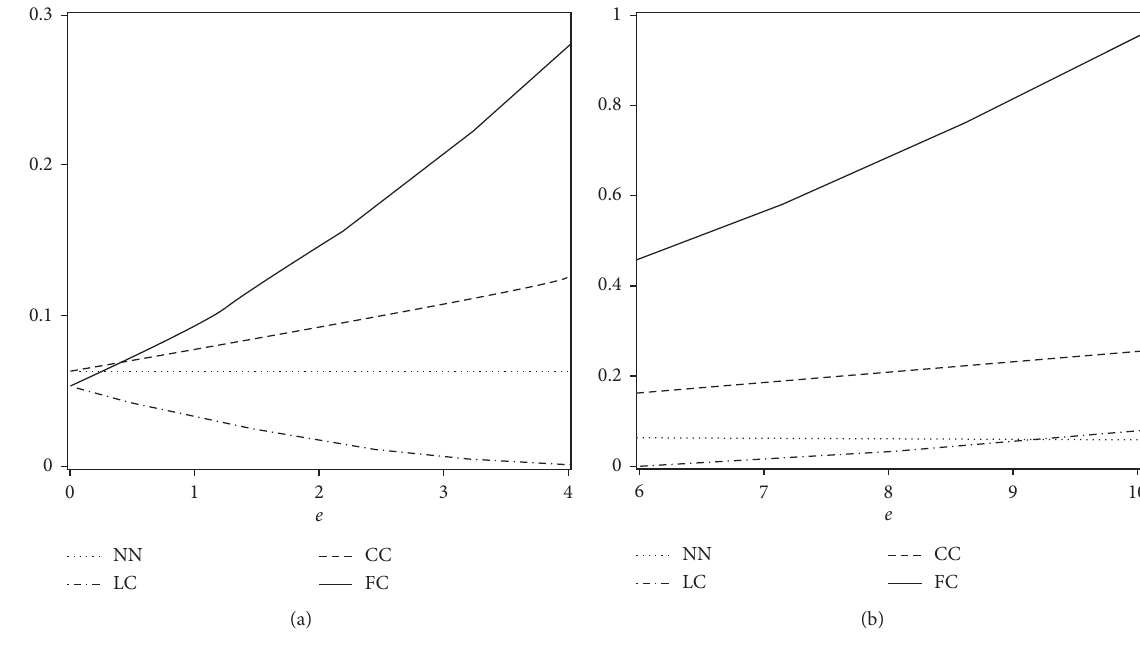
Figure 2: Comparison of the profits of University